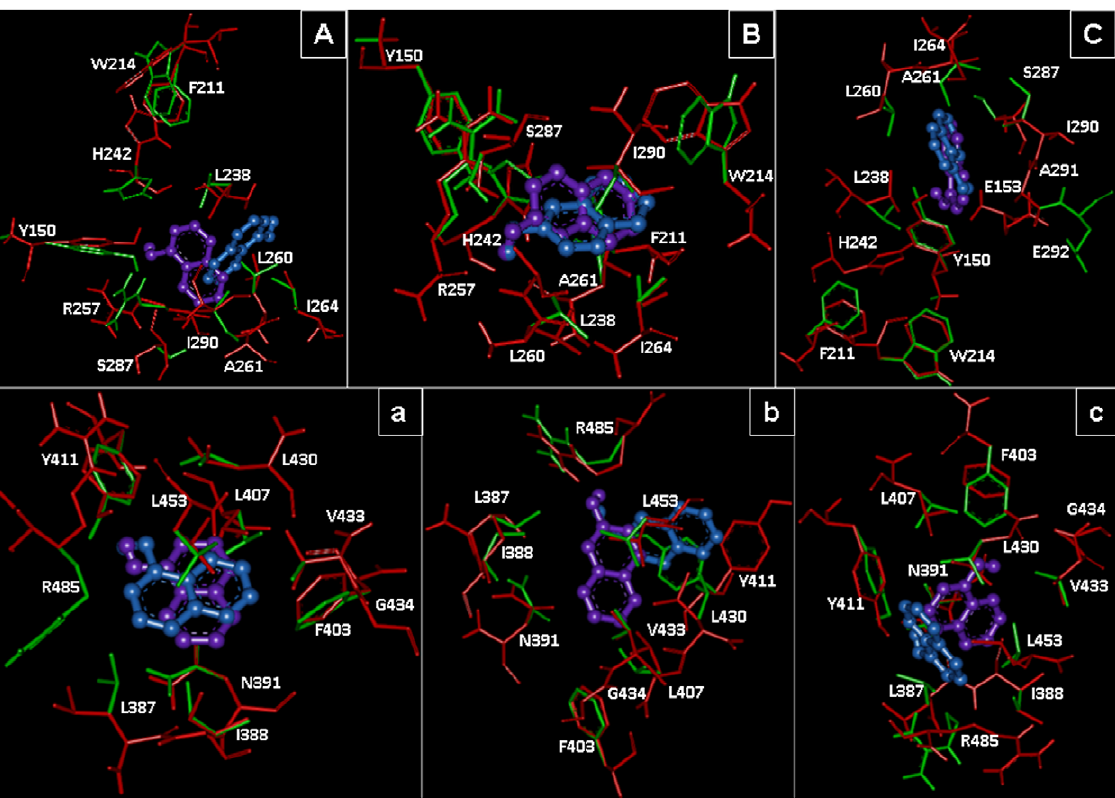
doi:10.1371/journal.pone.0026186.g012